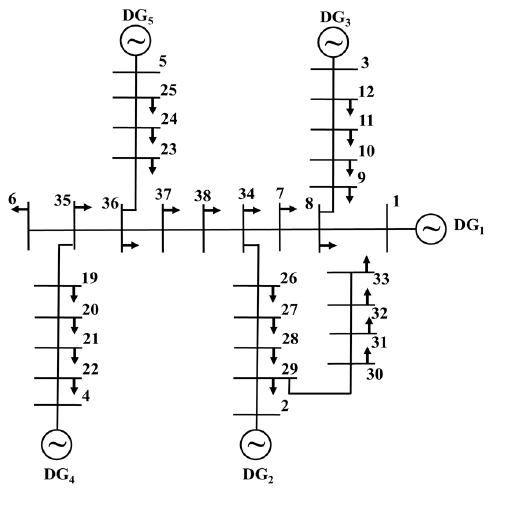
Figure 6. 9-bus system. ( a ) layout of the test system; ( b ) results of the optimization.